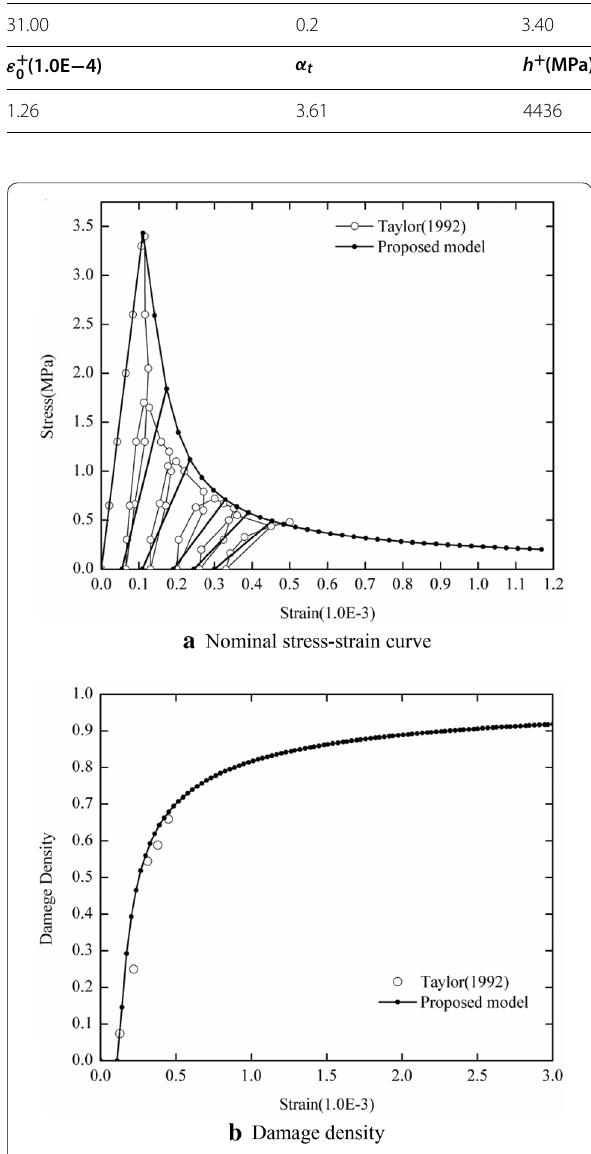
Fig. 7 The model responses in cyclic tension compared to experimental results presented in Taylor (1992).